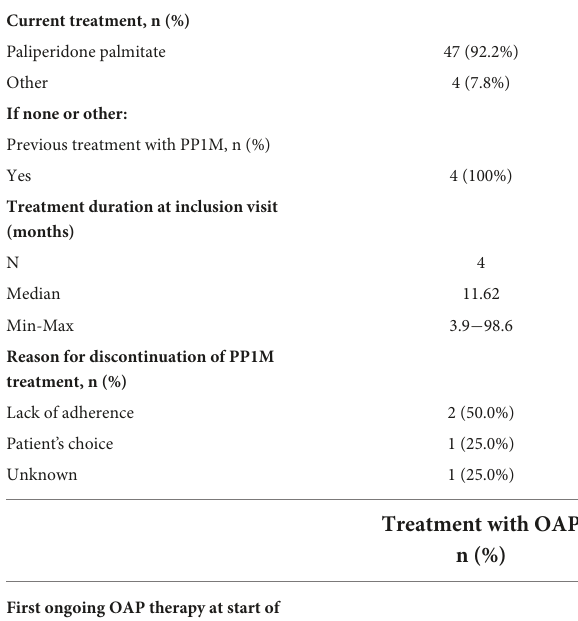
TABLE 2 Treatment characterization and OAP treatment at the inclusion